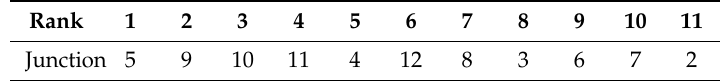
Table 8. Results of sensitivity analysis using the results of unsteady analysis.